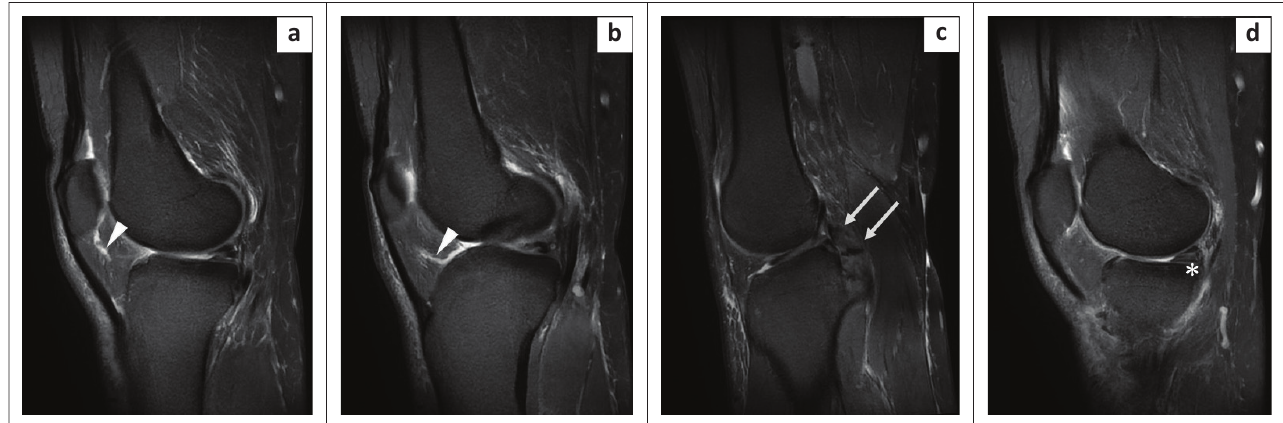
FIG URE 7: Magnetic resonance imaging of an infrapatellar plica tear in a 60-year-old female with a history of anterior knee pain: PDFS oblique sagittal image (a) shows a hyperintense fluid collection along the entire course of infrapatellar plica (arrow head) with oedema in the surrounding Hoffa’s fat pad. Oblique coronal PDFS (b) shows that the patient also had a high-grade partial thickness tear of the middle and upper thirds of both bundles of the anterior cruciate ligament (arrow).